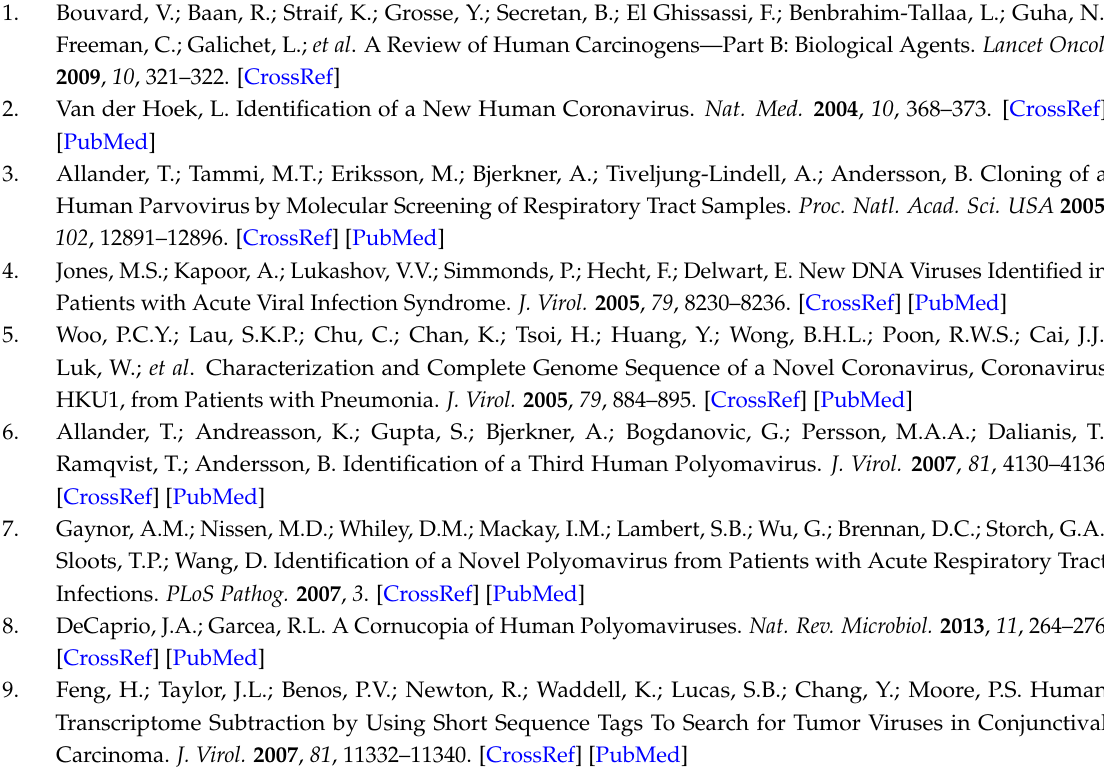
Table S1: Virus discovery pipelines, Table S2: Distribution of library types, Table S3: Methods in cancer samples, Table S4: Clustering parameters, Table S5: Feature descriptions, Table S6: Datasets in clusters, Figure S1: Clustering